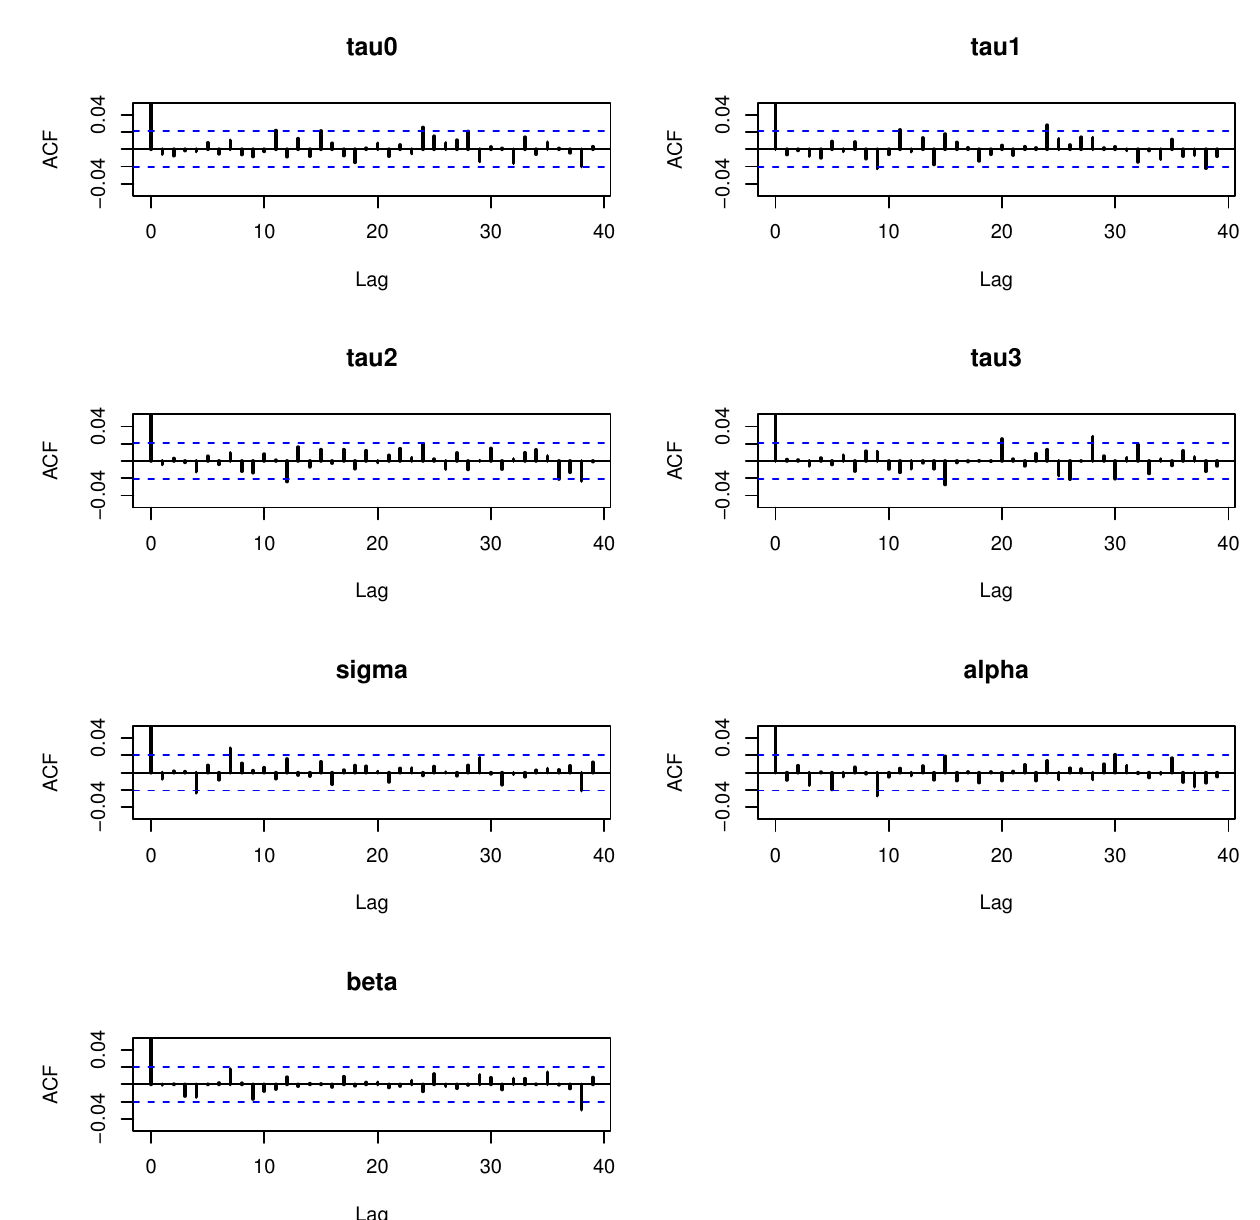
Figure 12. Autocorrelation race plots of Bayesian analysis and performance of Gibbs sampling for the each parameter of LATOLLW distribution based on the heart transplant